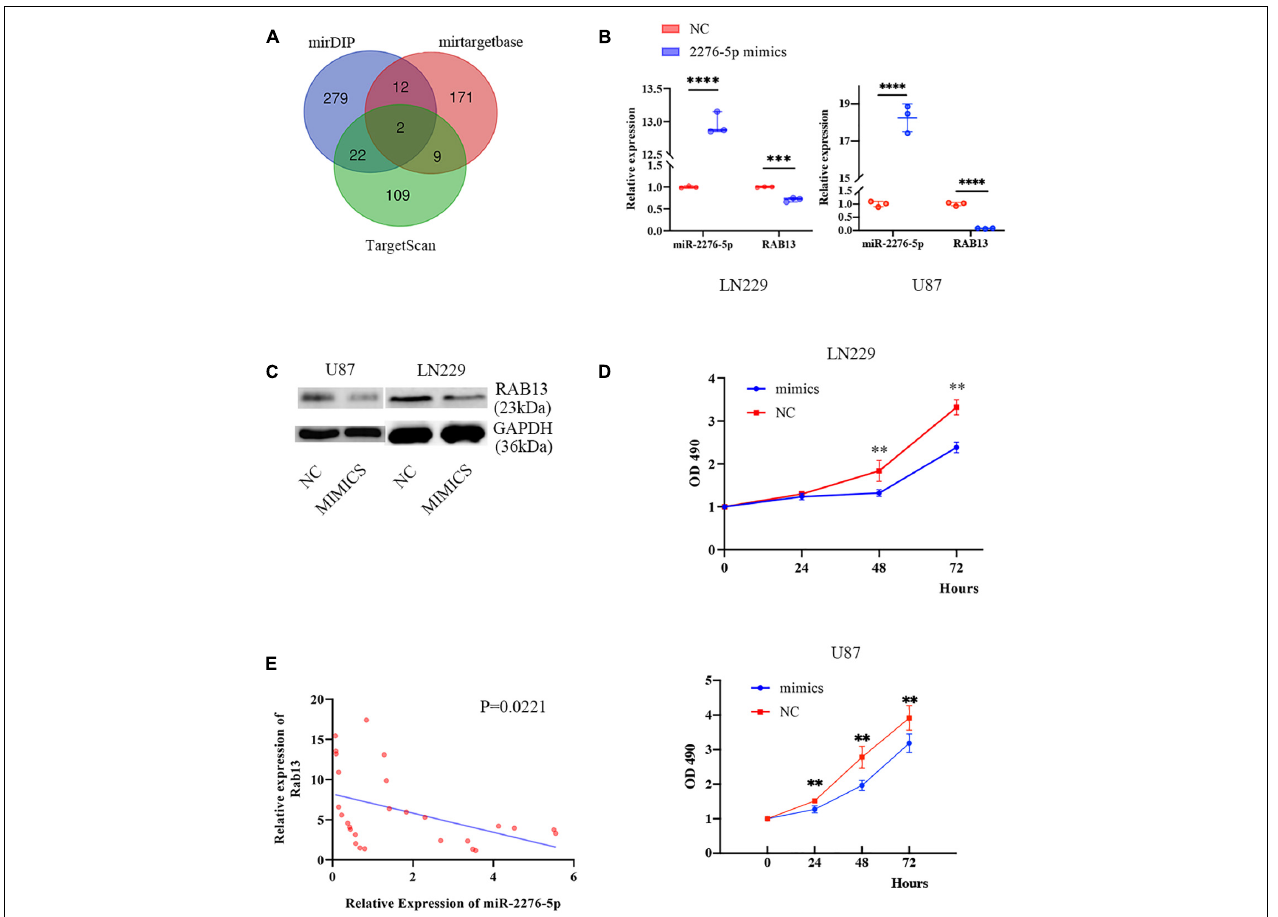
FIGURE 3 | RAB13 may be the target gene of miR-2276-5p. (A) The predicted result of target genes of miR-2276-5p, as determined by consultation with mirDIP, mirtargetbase, and TargetScan. (B) The relative expression of miR-2276-5p and RAB13 mRNA in LN229 and U87 glioma cell lines transfected with miR-2276-5p or the negative control (NC) mimics. (C) Western blotting results showing the expression levels of RAB13 protein in miR-2276-5p/NC- transfected LN229 and U87 glioma cell lines. (D) The cell proliferation state of miR-2276-5p/NC-transfected LN229 and U87 glioma cells, as determined by MTT. (E) The correlation of expression level of miR-2276-5p with the expression levels of RAB13 in glioma tissues. ∗∗ p < 0.01; ∗∗∗ p < 0.001; ∗∗∗∗ p <